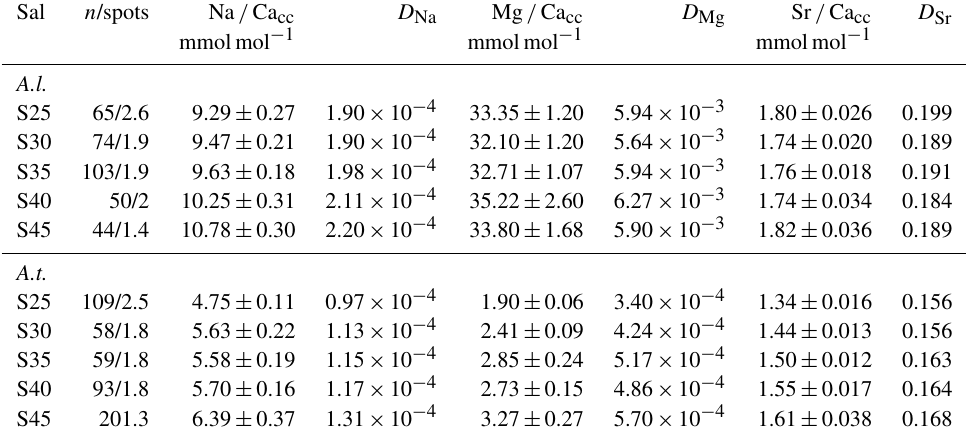
Table 3. Average El / Ca cc ratios of the foraminiferal calcite (based on average of average specimens value per salinity (Sal) condition (S25– S45)) ± standard error and corresponding apparent partitioning coefficients, defined as D El = (El / Ca cc ) / (El / Ca Seawater ) for A.